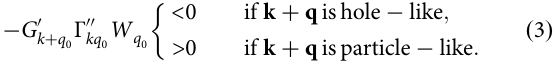
(dark blue) in steps 2